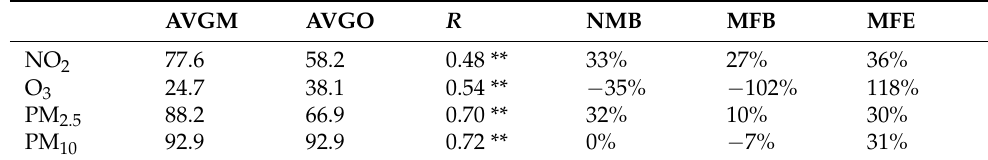
Table 4. Statistical analysis of simulated and observed hourly near-surface NO 2 , O 3 , PM 2.5 , PM 10